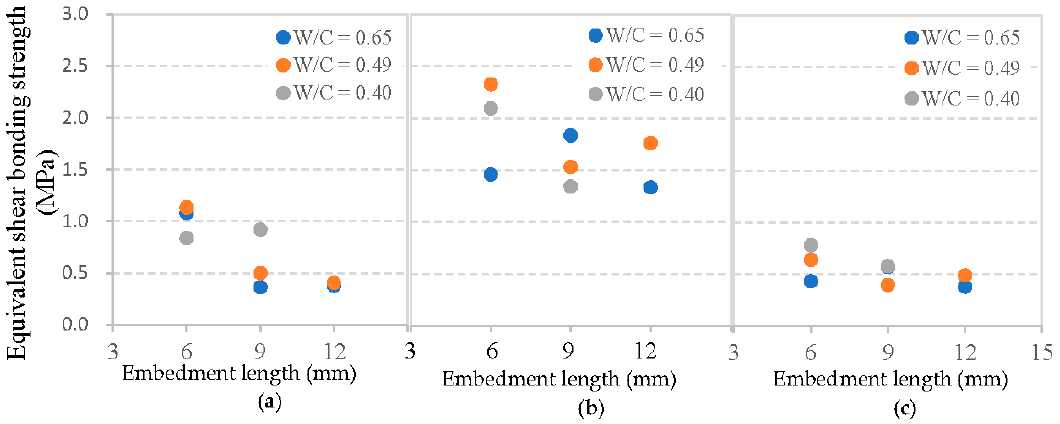
Figure 14. Equivalent shear bonding strength between cement matrix and: ( a ) basalt fiber, ( b ) PVA fiber, and ( c ) glass fiber.